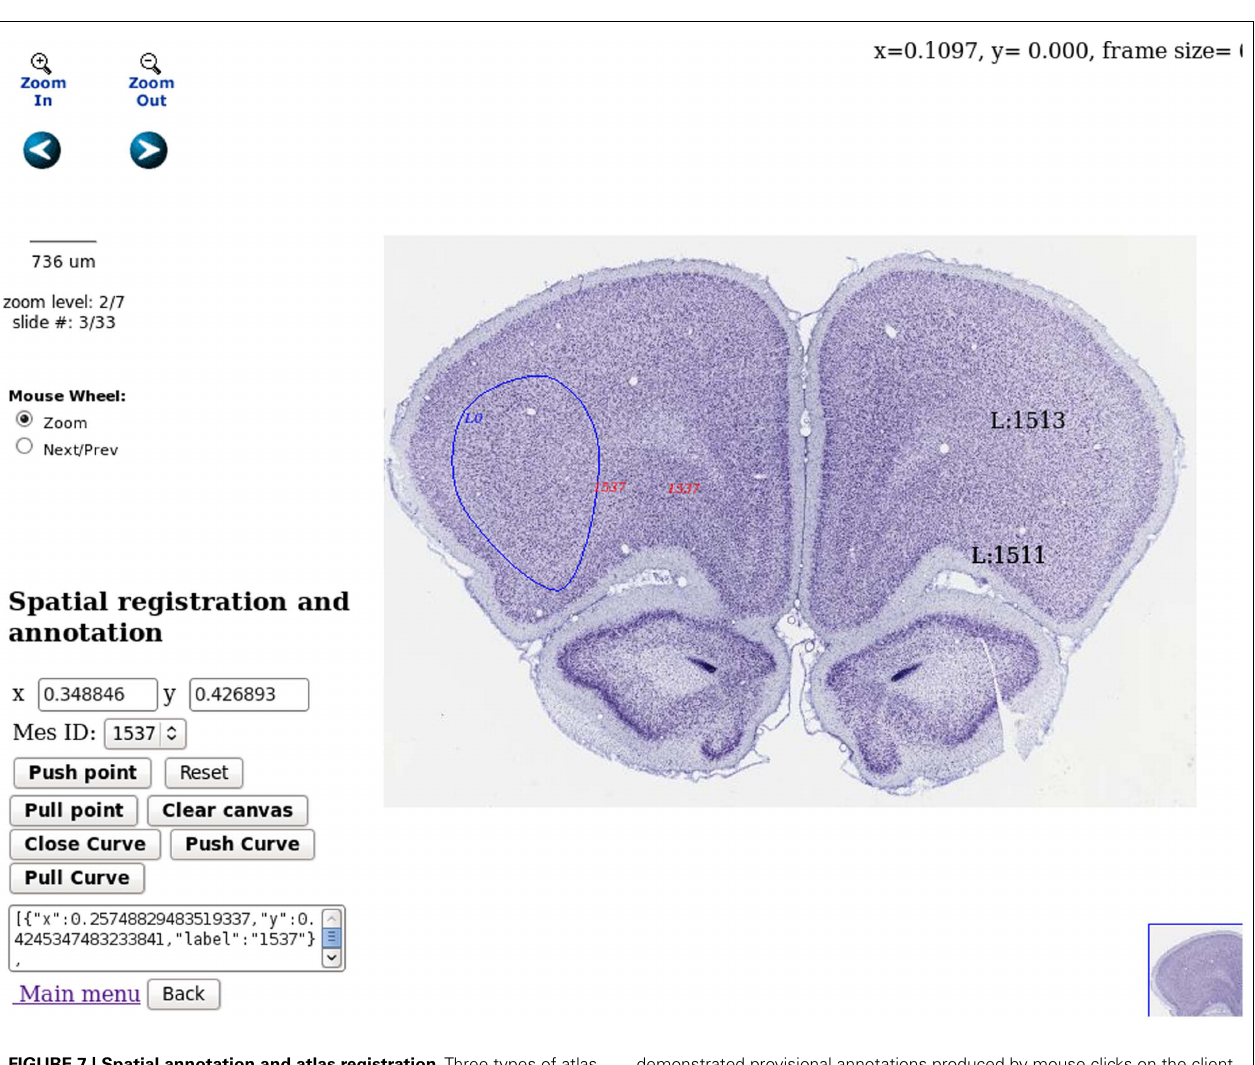
FIGURE 7 | Spatial annotation and atlas registration. Three types of atlas annotations are demonstrated in the figure. In solid blue is displayed a ROI annotation delineating a region in the frontal cortex, dataset r3778, Nissl stating, source Brain Maps, contributed by Jones (2007, http://brainmaps.org/index.php?action=metadata&datid=94). In red are